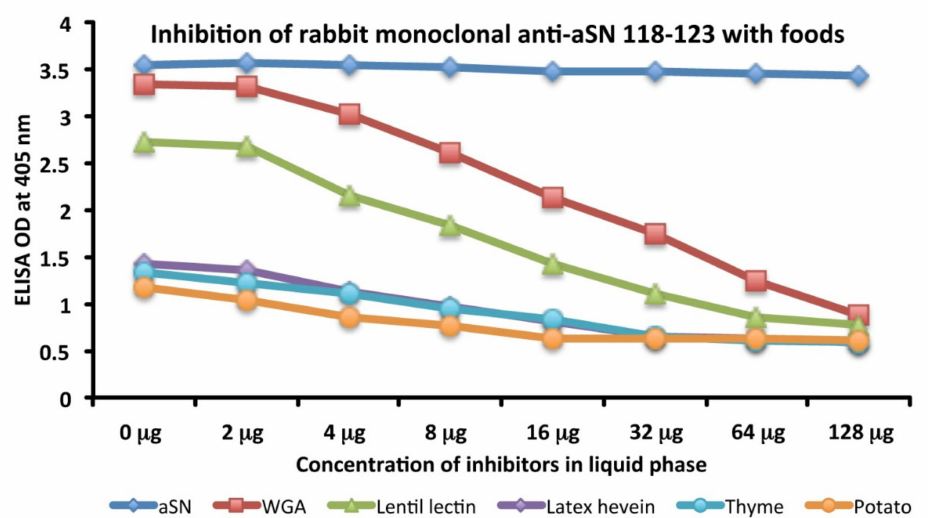
Figure 6. Analytical specificity by inhibition study for rabbit monoclonal anti-aSN epitope 118–123. Shown are the reactions of various dilutions of rabbit monoclonal anti-aSN antibody with aSN (blue diamond), WGA (red square), lentil lectin (green triangle), latex hevein (purple diamond), thyme (light blue circle) and potato (orange circle). aSN—Alpha-synuclein; WGA—wheat germ